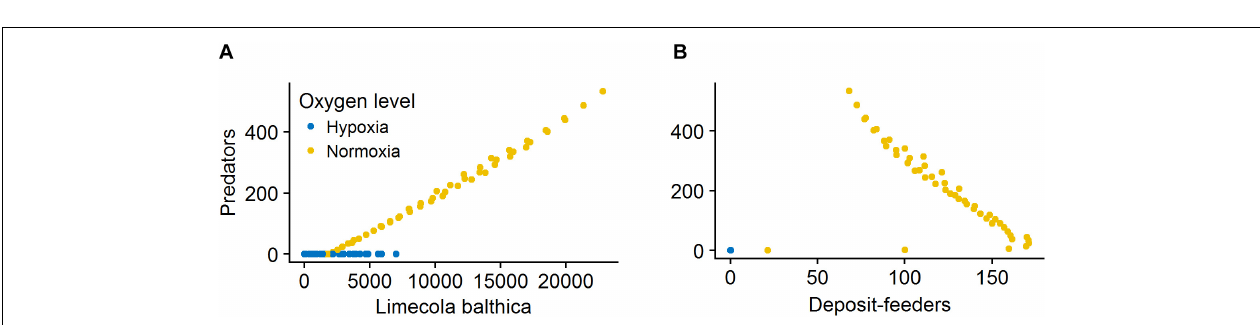
FIGURE 8 | Change in biomass of deposit-feeders (A) , L. balthica (B) , and predators (C) as a function of relative changes in O2Conc and TBot, where 1 denotes baseline forcing. Biomass change is relative to baseline equilibrium value. Error bars show the variability in biomass change due to varying Sed. Horizontal line indicates no change. Forcing abbreviations are explained in Table 1 .